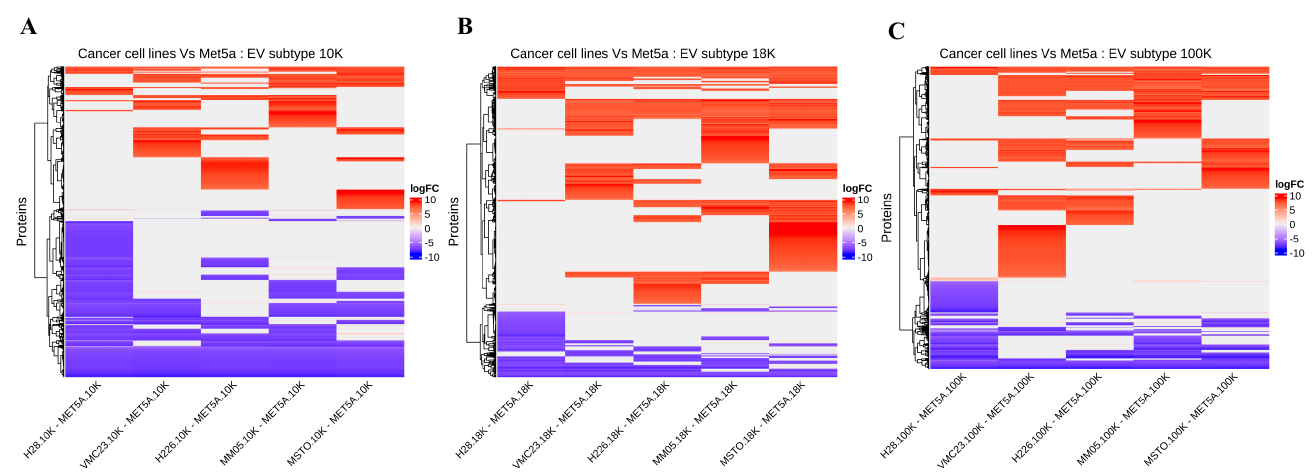
15 of 38 Figure 6. Heatmap representing the di ff erential abundance based on normal spectral count (SpC). ( A ) Heatmap of di ff erentially expressed proteins across all samples, including their biological and technical replicates, showing similarities and di ff erences between each of the EVs derived from pleu- ral mesothelioma cell lines. ( B ) Heatmap focusing on the di ff erential expression of common EV markers across each of the EV subtypes derived from pleural mesothelioma cell lines. Data obtained from four biological replicates. Protein abundance values represent the sum of all unique peptides for a speci fi c protein. We also investigated the top fi ve di ff erentially expressed proteins in each EV type compared to the corresponding EV type derived from the control cell line, MeT-5A (Figure 7). In the 10 K EVs, among the top di ff erentially expressed proteins, we found upregula- tion of leucine-tRNA ligase ( SYLC) , carbohydrate sulfotransferase 3 ( CHST3 ), neogenin (immunoglobulin superfamily DCC subclass member 2) ( NEO1 ), aldo-keto reductase family 1 member A1 ( AK1A1 ), and the toll-interacting protein ( TOLIP ). We also found downregulation of high-a ffi nity cAMP-speci fi c 3’,5’-cyclic phosphodiesterase 7A ( PDE7A), nucleolar and coiled-body phosphoprotein 1 ( NOLC1 ), micro fi brillar-associated protein 1 ( MFAP1 ), bisphosphoglycerate mutase ( PMGE ), cystic fi brosis transmembrane conductance regulator ( CFTR ), and pre-mRNA 3’-end-processing factor FIP1 ( FIP1 ) . In the 18 K EVs, among the top di ff erentially expressed proteins, we found upregulation of as- paragine synthetase ( ASNS ), platelet-derived growth factor receptor beta ( PGFRB ), vita- min K-dependent protein S ( PROS ), and ubiquitin-40S ribosomal protein S27a ( RS27 ), as well as downregulation of collagen alpha-1 ( COAA1 ) , protein IWS1 homolog ( IWSI ) , gel- solin ( GELS ) , and adenylate kinase isoenzyme 1 ( KAD1 ). In the 100 K EVs, some of the top di ff erentially expressed proteins include upregulation of aldo-keto reductase family 1